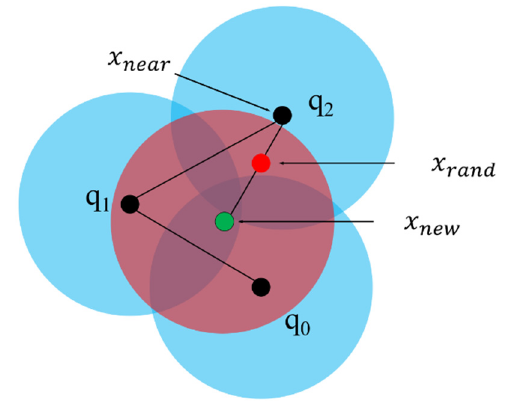
Figure 2. Schematic illustration of the invalid expansion caused by RRT’s random sampling strategy. 𝑥 (cid:3045)(cid:3028)(cid:3041)(cid:3031) is the randomly sampled point, 𝑥_𝑛𝑒𝑎𝑟 is the nearest neighbor of 𝑥 (cid:3045)(cid:3028)(cid:3041)(cid:3031) , and 𝑥 (cid:3041)(cid:3032)(cid:3050) is the expansion point. Unfortunately, this step of expansion is invalid because the random tree